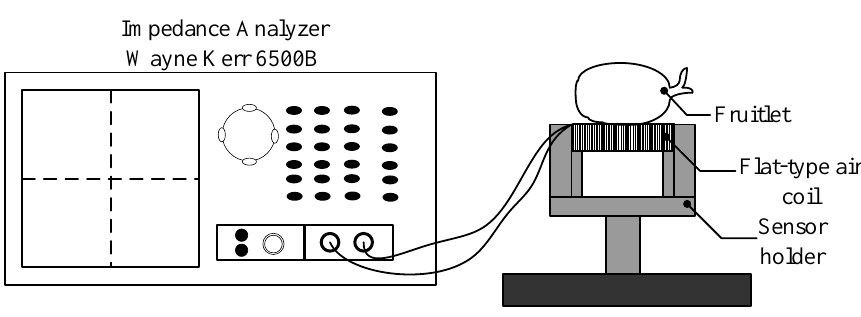
Figure 3. Experimental setup for the flat-type air coil.